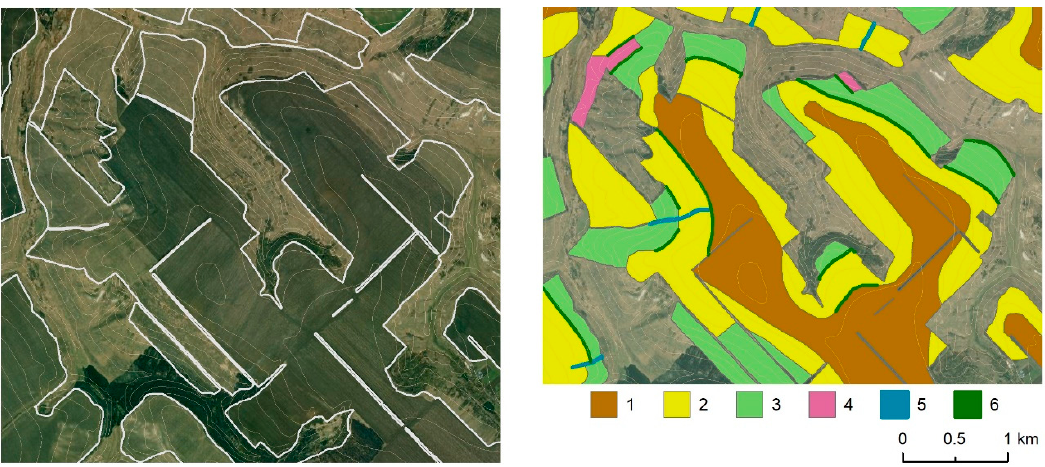
Figure 3. Cropland development proposals from the river-basin nature management project: the existing land use ( left ) and ALAS projects ( right ). 1—field crop rotation, 2—fodder/forage crop ro- tation, 3—soil-protection crop rotation, 4—cropland conservation, 5—grassing of hollows, and 6—contour forest belts.